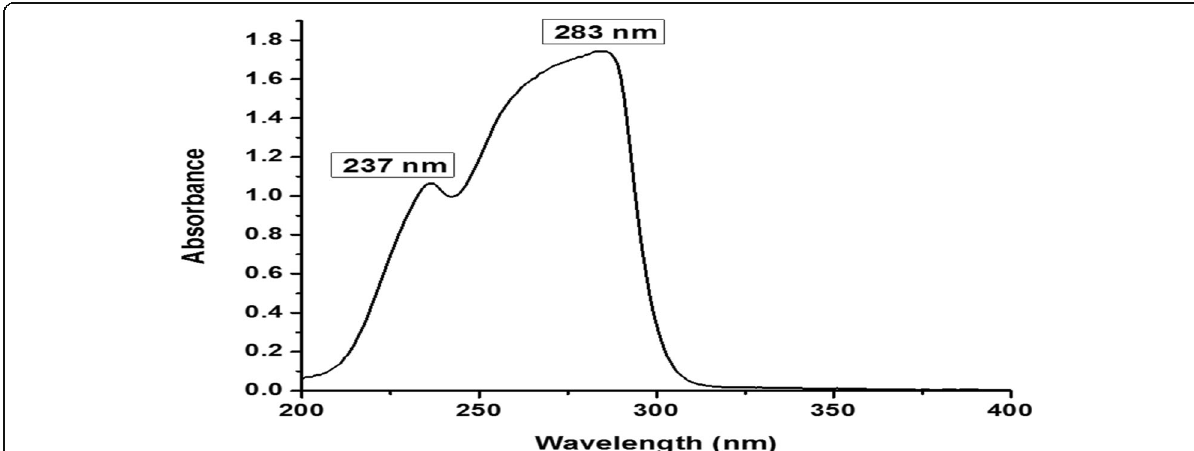
Fig. 5 UV absorption spectrum of killer toxins for Torulaspora delbrueckii (TK) toxin (10 mg/ml H2O) using UV-visible quartz cell with path length of 1 cm at 298